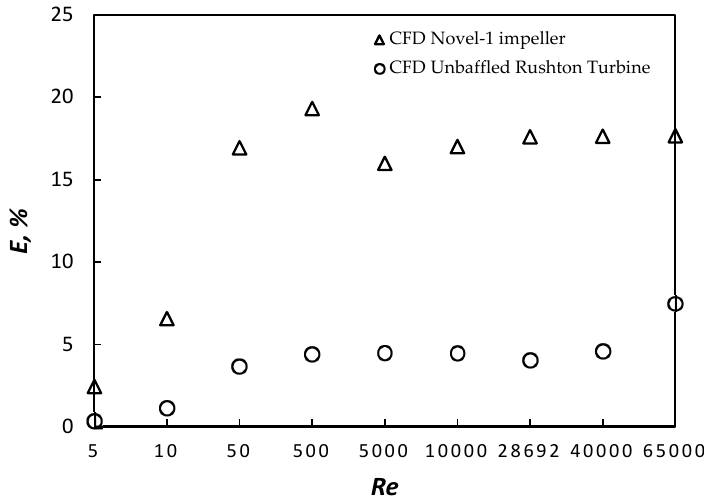
Figure 6. The e ffi ciency comparison for Rushton turbine and Novel-1 impeller as a function of Figure 6. The efficiency comparison for Rushton turbine and Novel-1 impeller as a function of Reynolds Reynolds number.